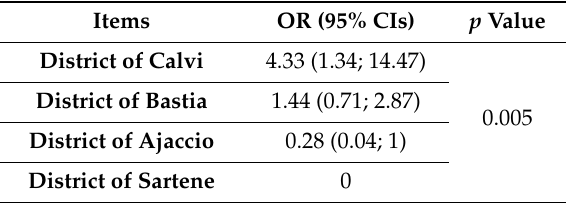
Table 2. Multivariate analysis of factors associated with Toscana virus seropositivity. Items